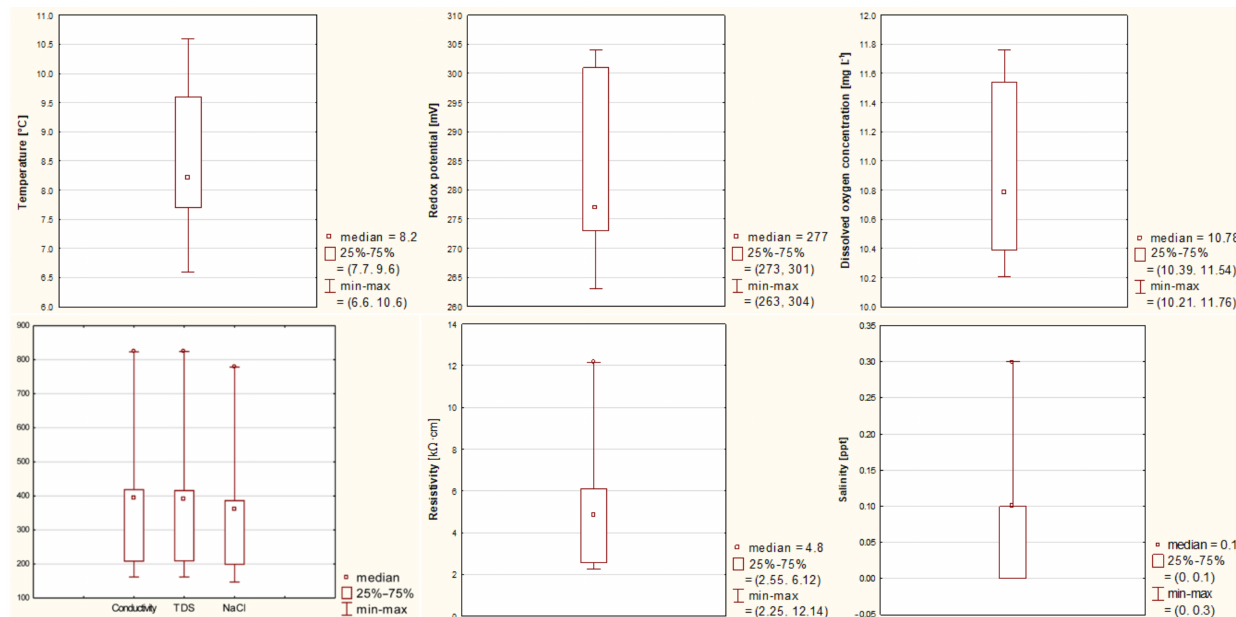
Figure 3. The measured values of physicochemical parameters in the water samples of the Slovinsk ý creek (Slovakia), expressed as descriptive statistics. (Note: TDS—total dissolved solids).